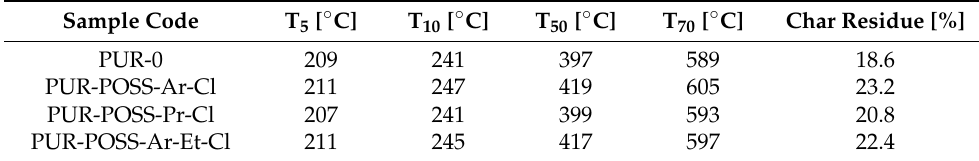
Table 3. Results of thermogravimetric analysis of PUR foams modified with POSS-Cl. Sample